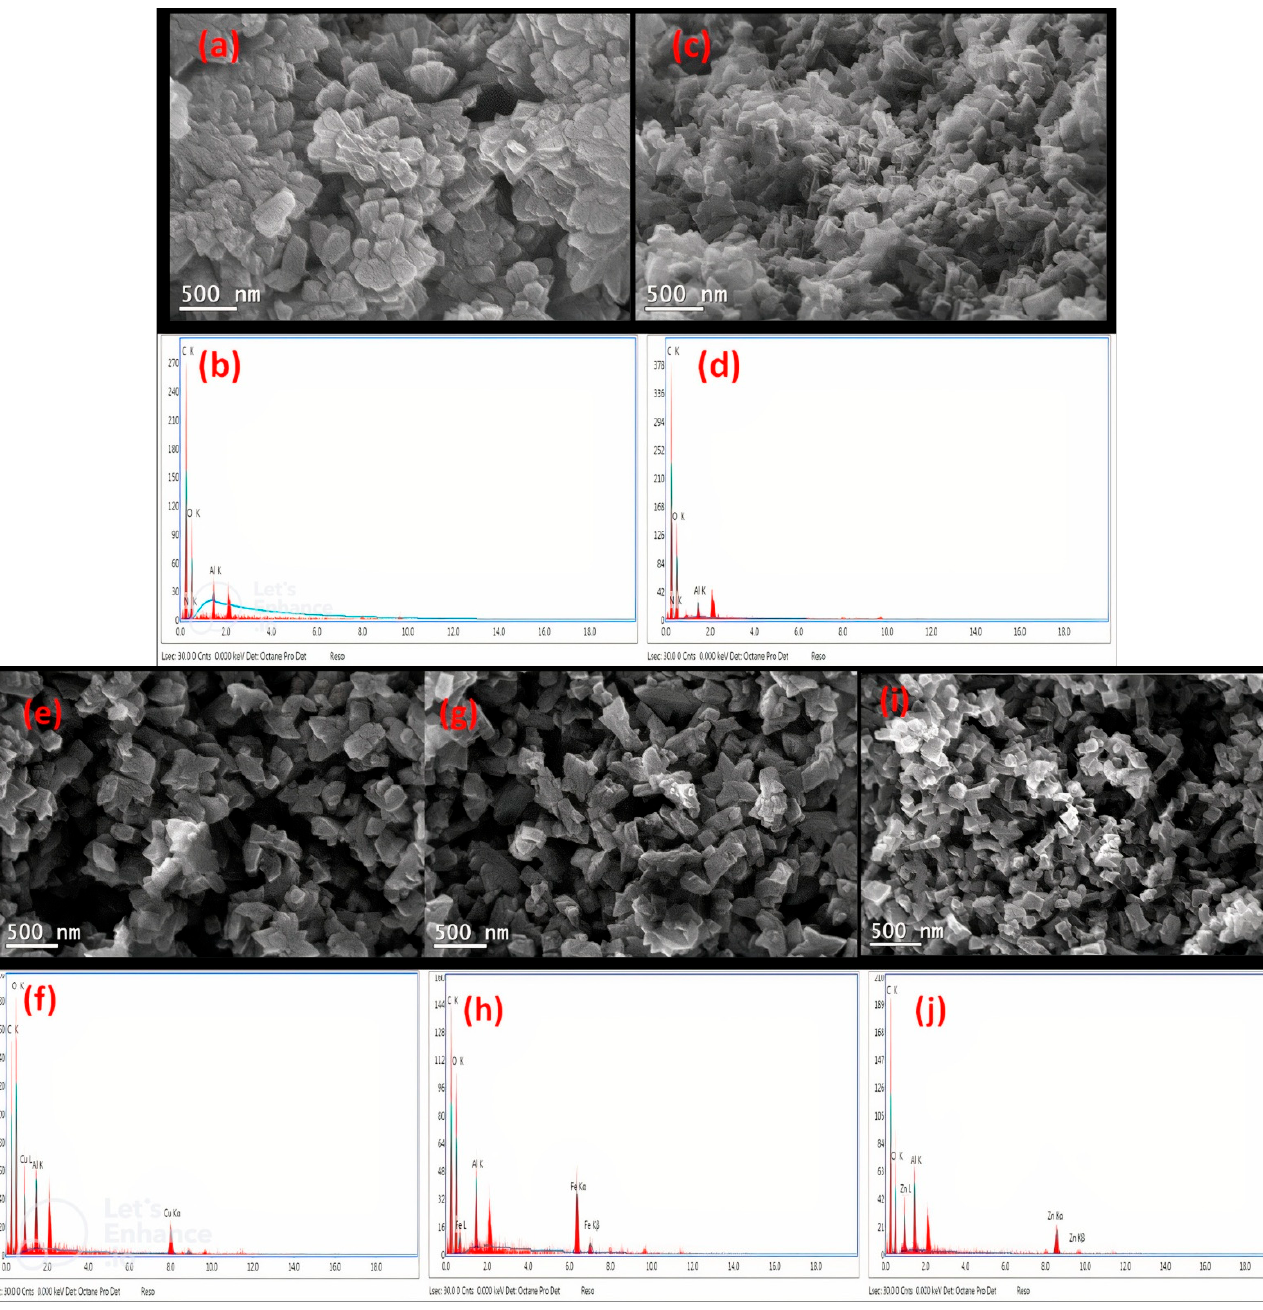
Figure 5. Scanning electron microscopic images and EDX spectra of ( a , b ) MIL-53-NH 2, ( c , d ) MIL-53-NH - Ph, ( e , f ) MIL-53-NH - Ph-Cu, ( g , h ) MIL-53-NH - Ph-Fe, and ( i , j ) MIL-53-NH - Ph-Cu. The elemental analysis of MIl-53-NH 2 , MIL-53-NH-ph, MIL-53-NH-ph-Fe, MIL-53-NH-ph-Zn, and MIL-53-NH-ph-Cu is given in Table 2. The carbon content was increased when MIl-53-NH 2 was modified with phthalic anhydride and then decreased with complexation with the metals. Interestingly, the ratio of aluminum ions decreases with the introduction of metal ions into MIL-53-NH-ph-Fe, MIL-53-NH-ph-Zn, and MIL-53-NH-ph-Cu. The surface areas of MIl-53-NH 2 , MIL-53-NH-ph, MIL-53-NH-ph-Fe, MIL-53-NH-ph-Zn, and MIL-53-NH-ph-Cu were 1060, 950, 750, 725, and 730 m 2 g − 1 , re- spectively. On the basis of these data, the surface area was decreased upon the complex- ation with metals.